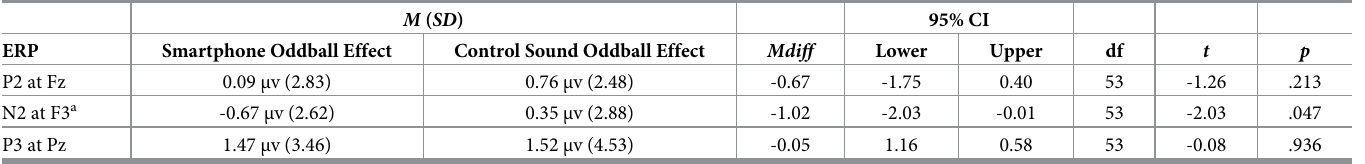
ERP oddball effect amplitudes (in microvolts) on the oddball task for trials with smartphone and control sounds. ERPs were time-locked to the presentation of the visual stimulus. a N2 is a negative going potential, thus smaller values indicate larger ERP amplitude. Dependent Variable = ERP mean amplitude oddball effect. CI = confidence interval.